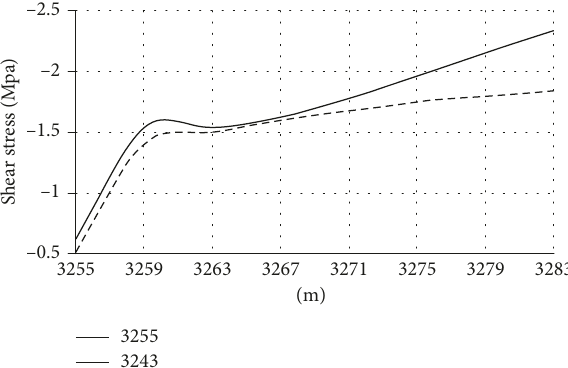
Figure 20: Diagram of maximum shear stress corresponding to change in the water level in two horizontal shear stress regions of the first-stage